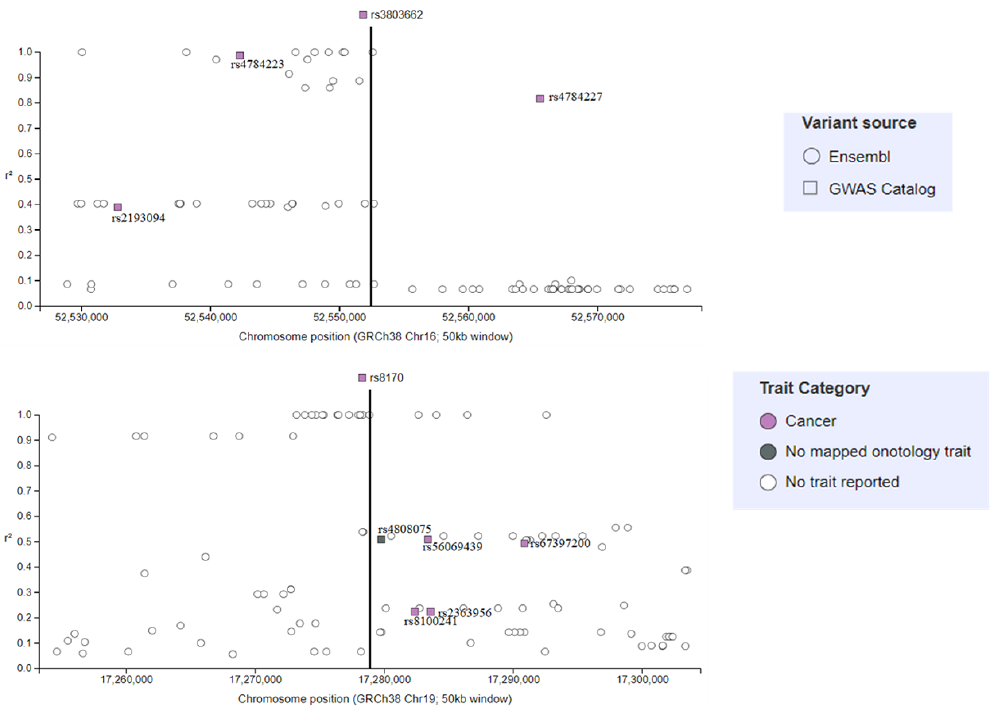
Figure 4. Correlations of the two most studied SNPs associated with triple negative breast cancer and other nearby SNPs identified following analysis of the GWAS catalogue. Abbreviations: SNPs, single nucleotide polymorphisms; GWAS, Genome-wide association studies.